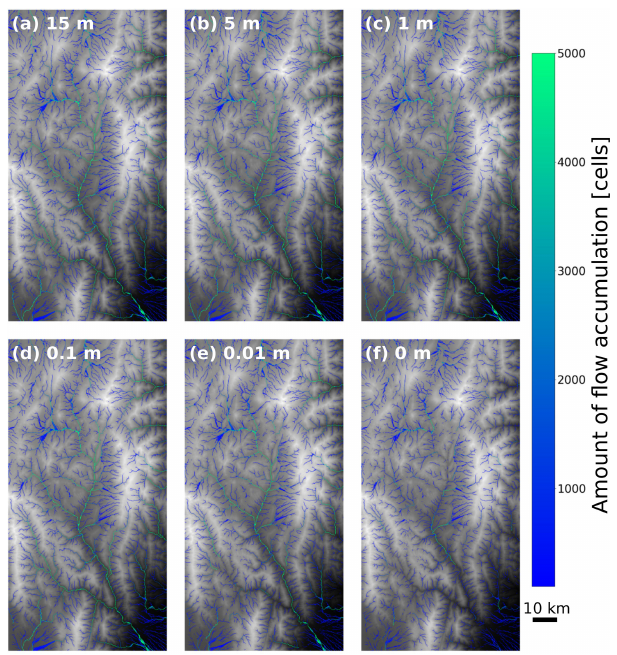
Figure 8. Drainage networks on partially filled landscapes at the Río Toro site. Flow networks were created using the FlowAccumu- lation method included in RichDEM (Barnes et al., 2014a; Barnes, 2016) with the result masked to show only cells with a flow ac- cumulation greater than 100. Hydrologic connectivity changes de- pending on how many depressions remain in the landscape. The unfilled depressions associated with each panel are shown in Fig. 7. The colours indicate the amount of flow accumulation in stream channels. Higher runoff depths applied to FlowFill fill more depres- sions and increase hydrologic connectivity. (a) With 15m of runoff, all depressions were filled so the result is identical to a flow-routing surface created with other flood fill techniques. The drainage is fully integrated. In (b, c) , with 5 and 1m of runoff depth, respectively, hydrologic connectivity changes only slightly. The depressions that appear with these amounts of runoff are near the headwaters of the river network, making the changes in hydrologic connectivity in these cases minimal. In (d, e) , reduced runoff starts to create more disconnects in the stream network. Panel (f) shows the origi- nal DEM, which has the lowest degree of hydrologic connectivity. Strahler stream orders associated with each panel are shown in Ta- ble 4.